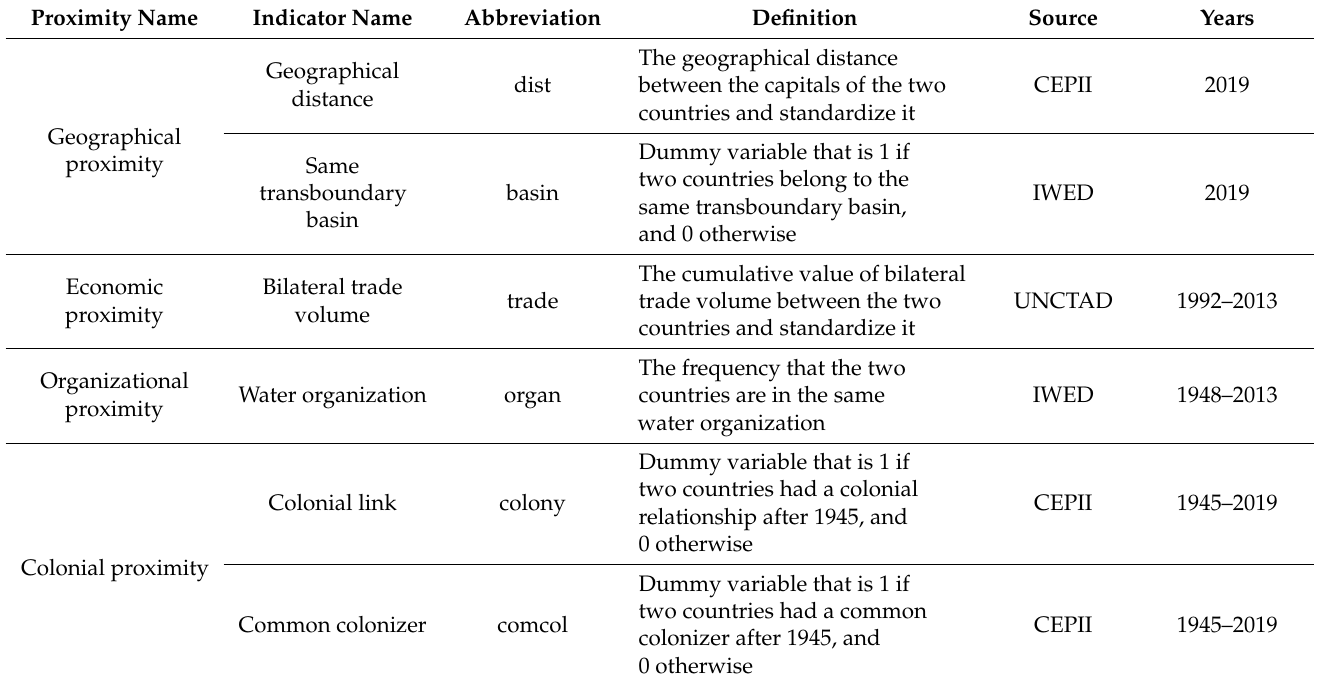
Table 1. Definition of proximity indicators and their data